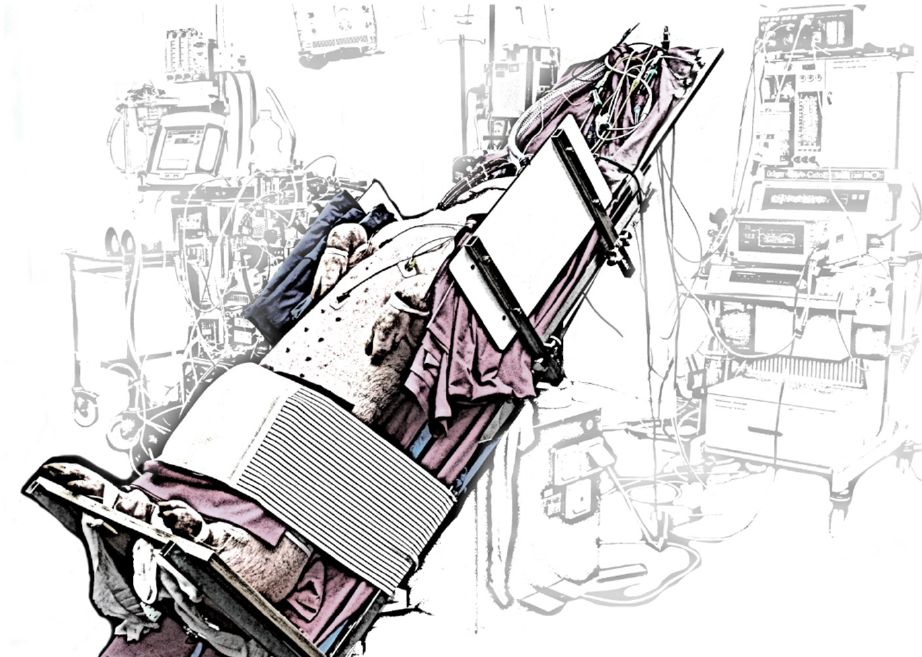
Figure 6. 45° Reverse Trendelenburg position with abdominal compression. The animals were placed on the operating table, a robust board was mounted below their back hooves, and the compression strap was tightened around the animal abdomen and the operating table.